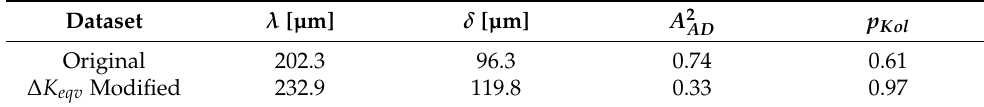
Table 6. Estimated Gumbel distribution parameters and goodness of fit test.